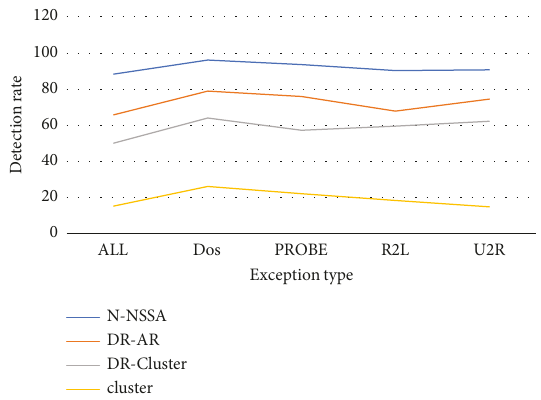
Figure 5: Comparison of detection rates of four